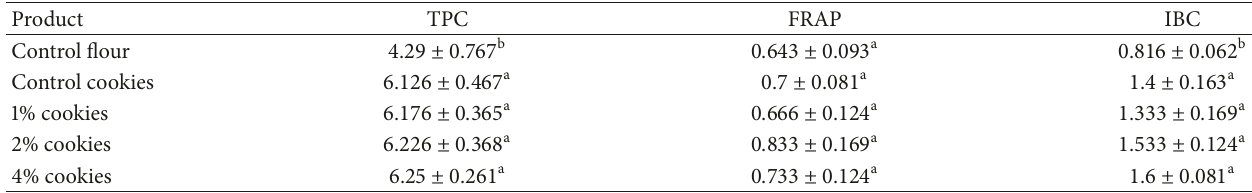
Table 3: Antioxidant properties of cookies made with 𝛽 -glucan compared to the control cookies and control flour. Product Control